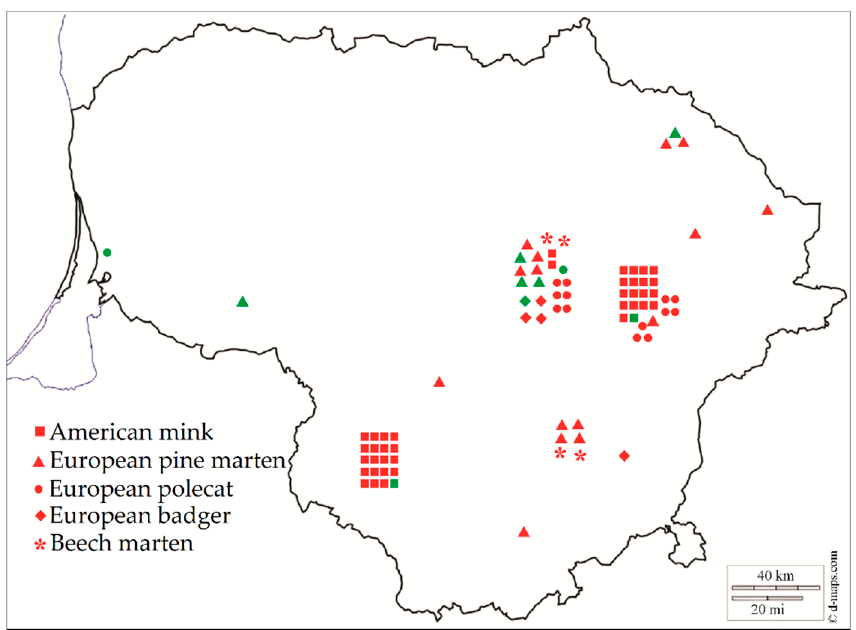
Figure 1. Sarcocystis spp. in the species of Mustelidae in Lithuania. Red color means positive individuals, green color represents negative individuals.